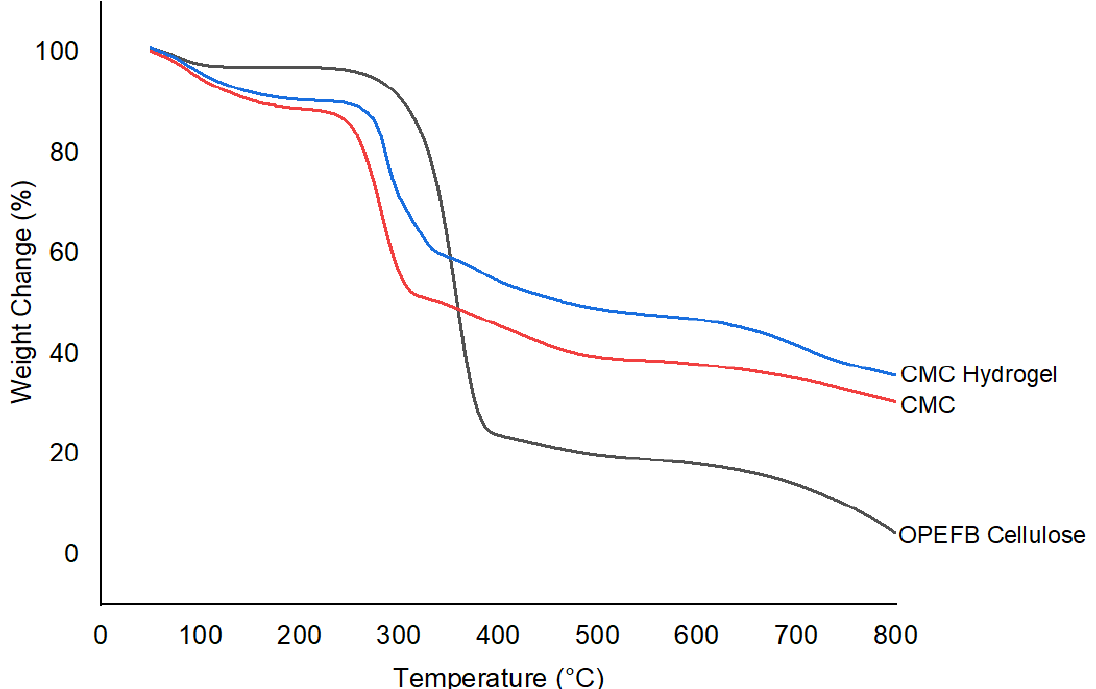
Figure 10. TGA thermograms of OPEFB cellulose, CMC, and CMC hydrogel. The first decomposition stage for OPEFB cellulose, CMC, and CMC hydrogel was due to the loss of bound water, as well as the release of any volatile compounds from the surface and moisture entrapped inside the sample. The release of initial moisture is common in natural fiber. As depicted in TGA–DTG thermograms, small weight losses of OPEFB cellulose, CMC, and CMC hydrogel were observed at a temperature of 78.33 ◦ C, 90.83 ◦ C, and 96.66 ◦ C, respectively. According to Mohtar et al. [35], any degradation or decomposition below 100 ◦ C is not considered as a significant thermal event in the TGA study. The second decomposition stage was the most crucial stage for all three samples. The decomposition temperature of OPEFB cellulose started at 206.54 ◦ C to 526.68 ◦ C with a weight loss of 77.79% from its original weight, while CMC decomposed at the temperature range of 180.31–527.32 ◦ C with a weight loss of more than half of the